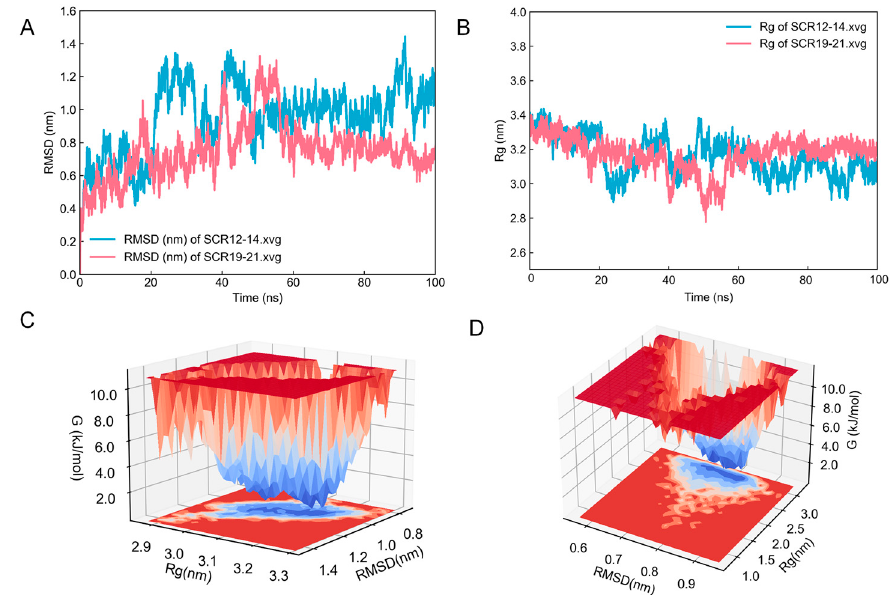
Figure 2. Molecular dynamics simulation and principal component analysis of CR1-like. ( A ) Back-